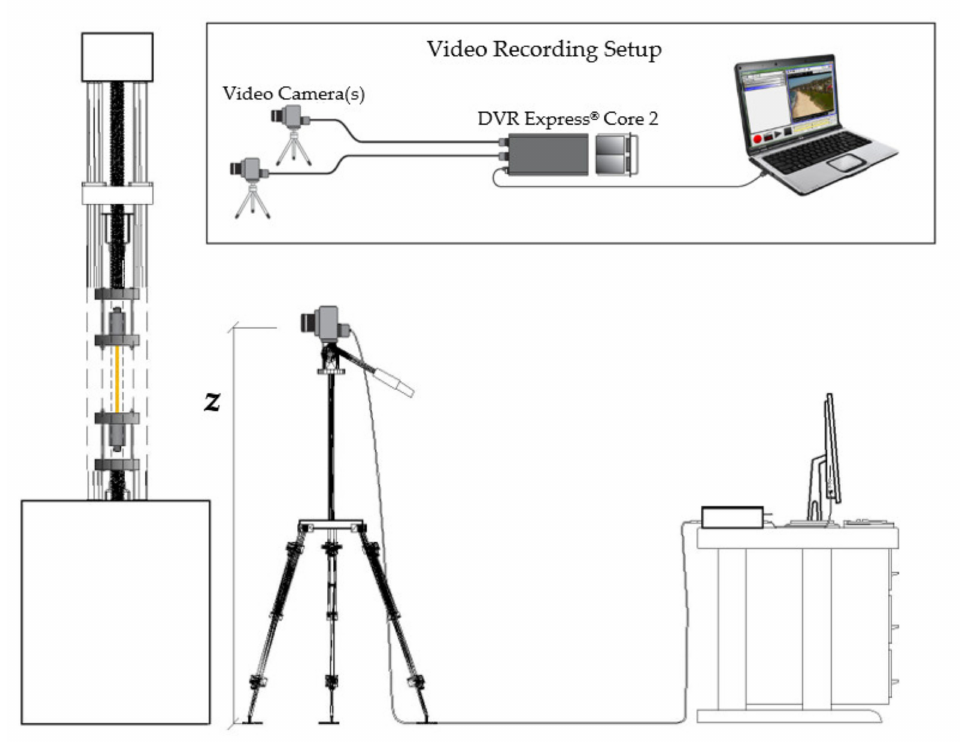
Figure 17. DIC acquiring system.